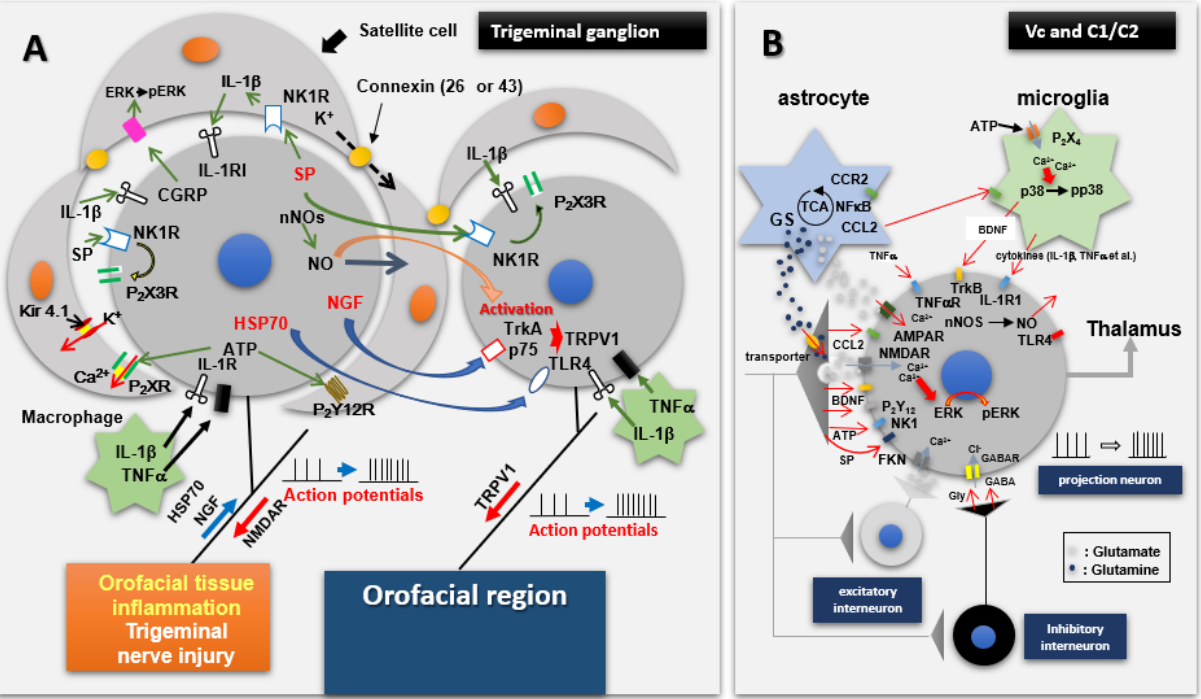
Figure 2. Mechanisms involved in initiation and transmission of nociceptive afferent information from orofacial tissues. ( A ) shows that trigeminal nerve injury or orofacial inflammation can induce hyperexcitability of trigeminal primary afferent neurons, satellite glial cell activation and macrophage accumulation. The hyperactivated trigeminal ganglion (TG) neurons as well as the satellite glial cells and macrophages communicate with each other through a variety of mediators, receptor mechanisms and signalling processes, many of which are shown here. Through this communication, further enhancement of the excitability of TG afferent neurons may occur, as manifested in their hyperexcitable input into components of the trigeminal brainstem sensory nuclear complex, in particular the medullary dorsal horn (also known as trigeminal subnucleus caudalis [Vc]), as well as the upper cervical spinal cord (C1/C2). ( B ) shows input and output features of nociceptive neurons in the medullary dorsal horn and C1/C2 under normal conditions as well as pathological conditions such as trigeminal nerve injury or orofacial inflammation which produces the hyperexcitable nociceptive afferent input shown in A. This input releases mediators which cause the neurons to become hyperactive, resulting in activation of microglia and astrocytes. Neuron–glial cell communication via various molecules, several of which are shown here, is important in fostering the hyperexcitable state of the neurons, i.e., central sensitization. From Iwata and Sessle